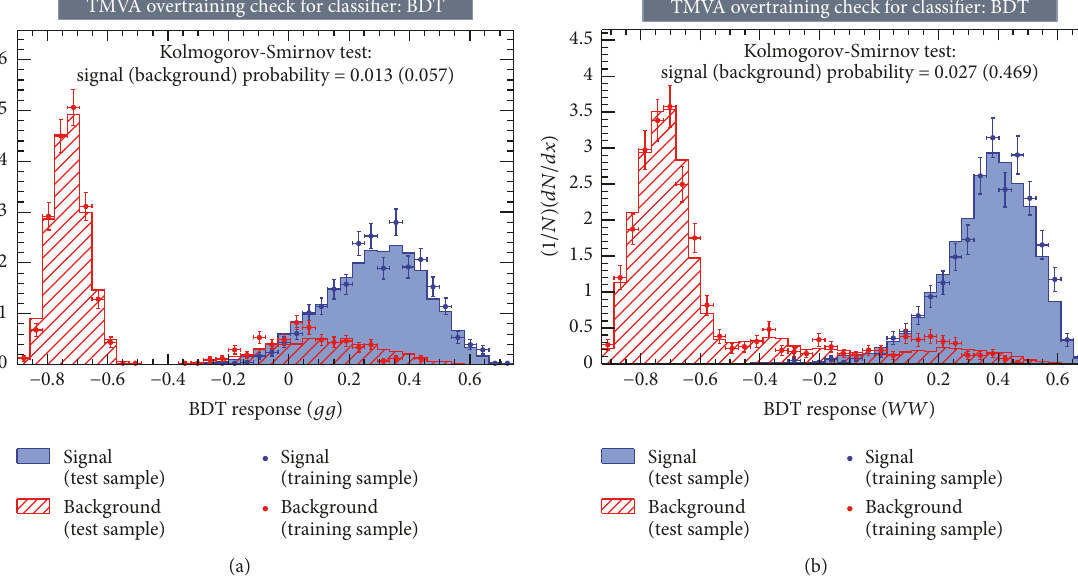
Figure 10: The BDT response for the signal ((a) 𝑔𝑔 fusion and (b) 𝑊𝑊 fusion) and the background for 𝑀 Φ = 1 TeV at the √ 𝑠 = 13 TeV